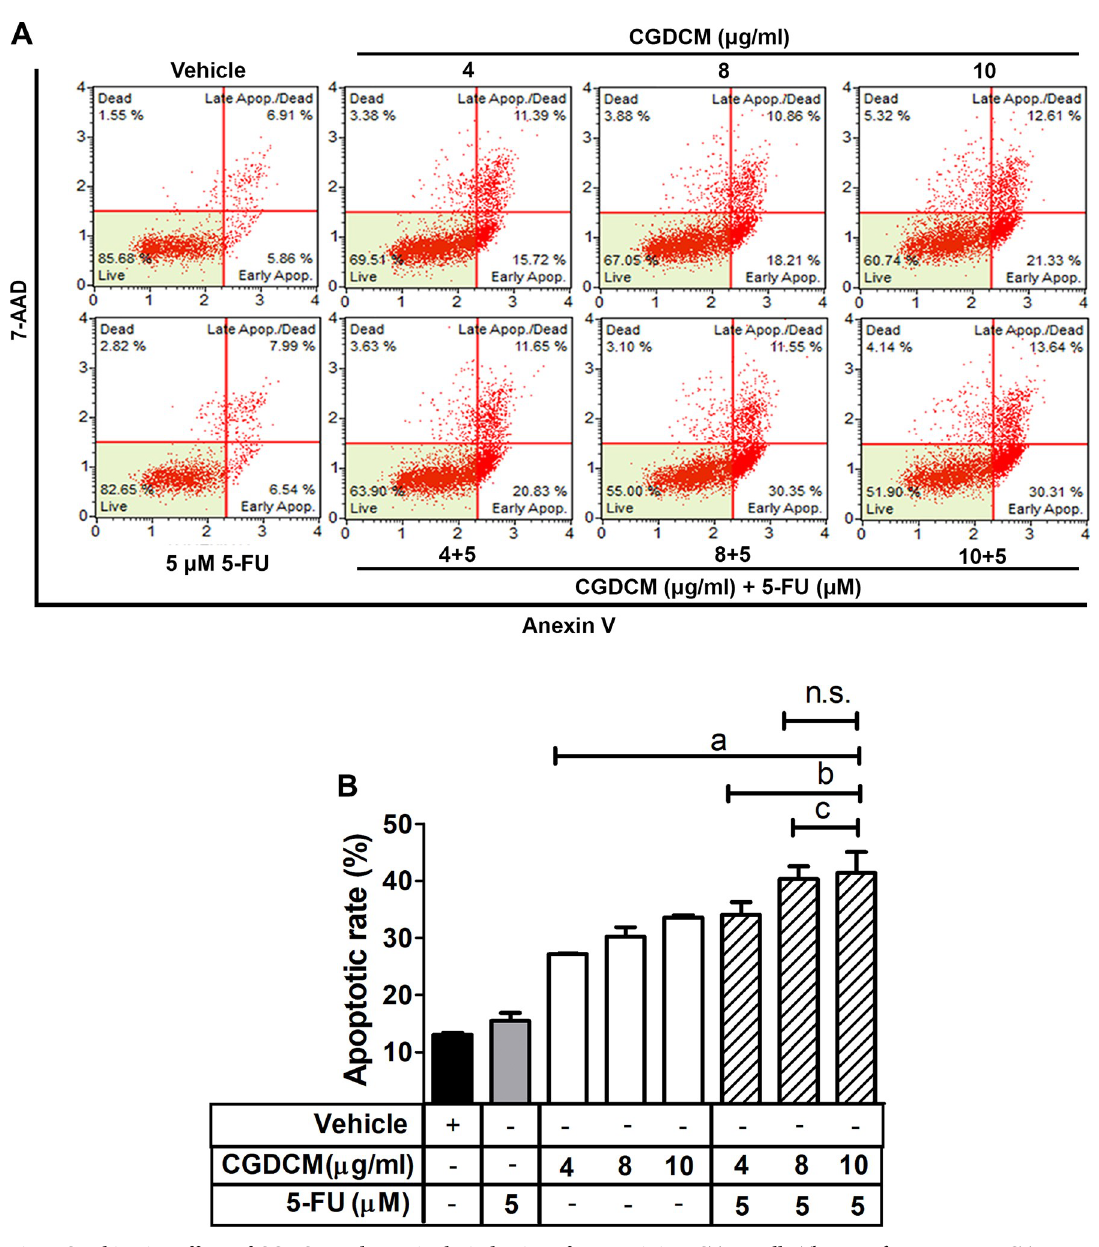
Fig 3. Combination effects of CGDCM and 5-FU in the induction of apoptosis in HCT116 cells. The rate of apoptosis in HCT116 cells treated with CGDCM, 5-FU, and combinations of CGDCM (4, 8, and 10 μ g/mL) with 5-FU (5 μ M or 0.65 μ g/mL) for 24 h. The total number of apoptotic (early and late) cells was evaluated by double staining with annexin-V and 7-AAD ( A ) and calculated as a percentage of the total cells ( B ). DMSO (0.8%) was used as the vehicle. The data are presented as mean ± SD, and were analyzed by one- way ANOVA with Tukey’s HSD test. a; p < 0.05 vs. vehicle group. b; p < 0.05 vs. 5-FU group. c; p < 0.05 vs. treatment with CGDCM alone. Abbreviations: CGDCM, C . gigantea dichloromethane extract; 5-FU, 5-fluorouracil; 7-ADD, 7-amino-actinomycin